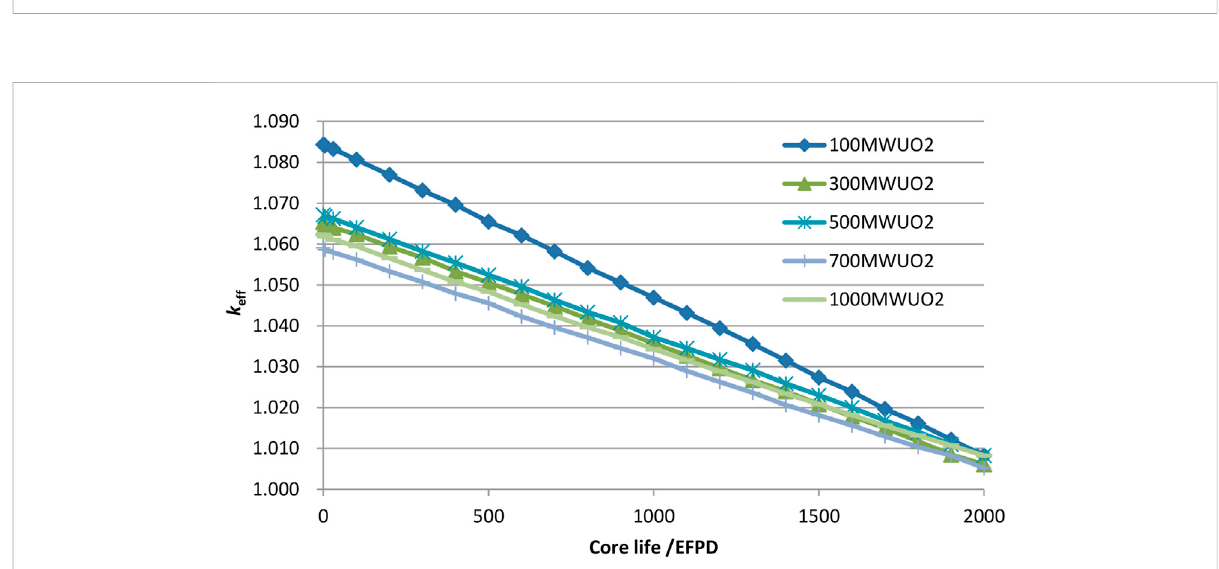
FIGURE 8 Core k eff curves of all the schemes with UO 2 fuel along with core